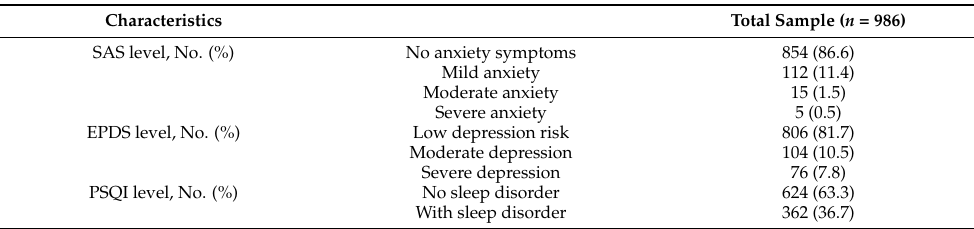
Table 1. Distribution of anxiety, depression symptoms and sleep disorders in pregnant women during the COVID-19 pandemic